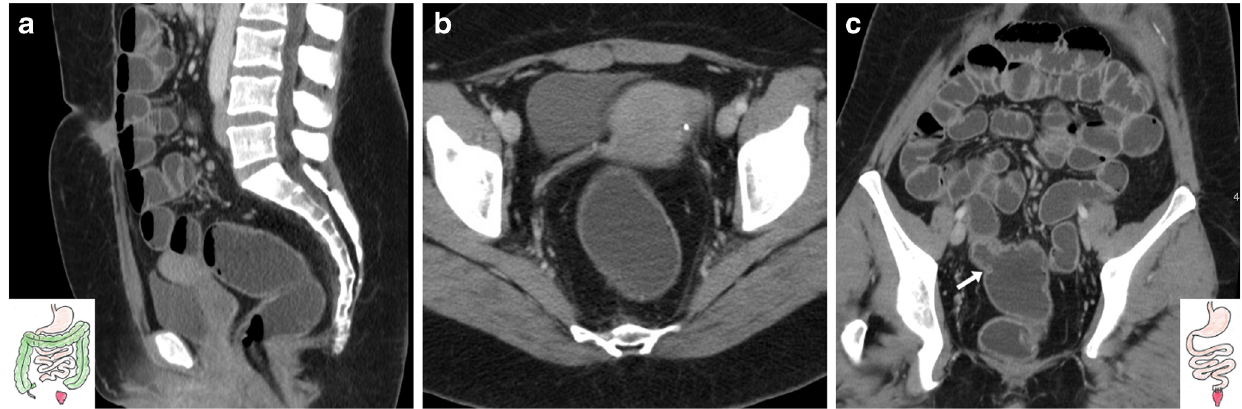
Fig. 5 Expected postoperative status following subtotal colectomy (surgical scheme shown in insets) in a 45-year-old female with ulcerative colitis. WE-MDCT ( a – c ) showed a well-distended rectum with